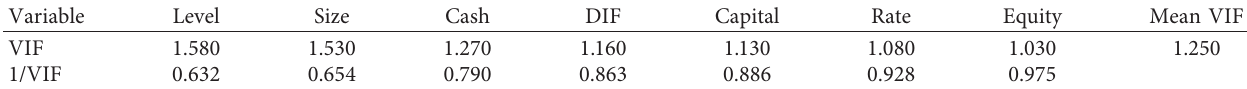
Table 1: VIF expansion factor.